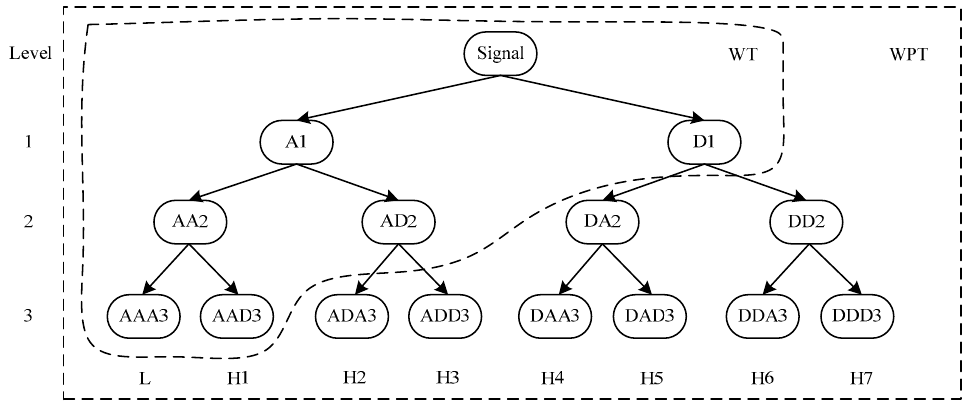
Figure 1. Comparison between three-level wavelet transform (WT) and three-level wavelet packet transform (WPT).